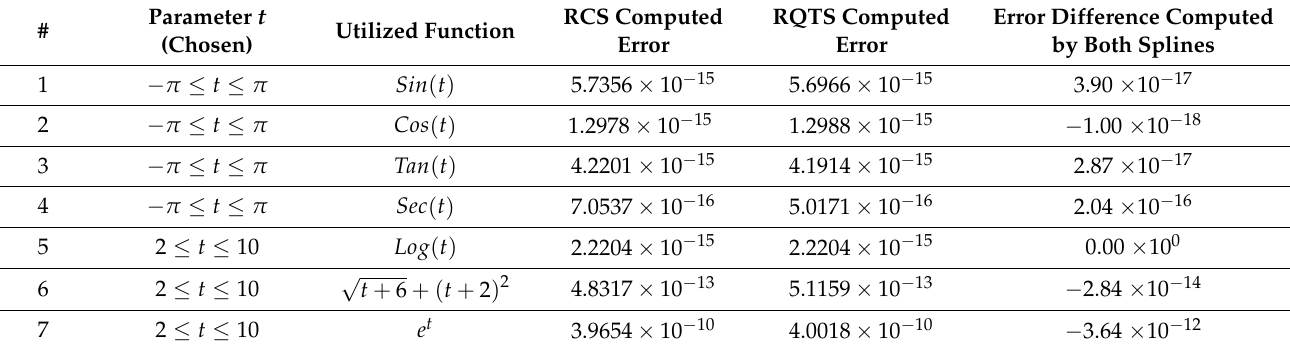
Table 2. Table of error study, for RCS and RQTS, for a various